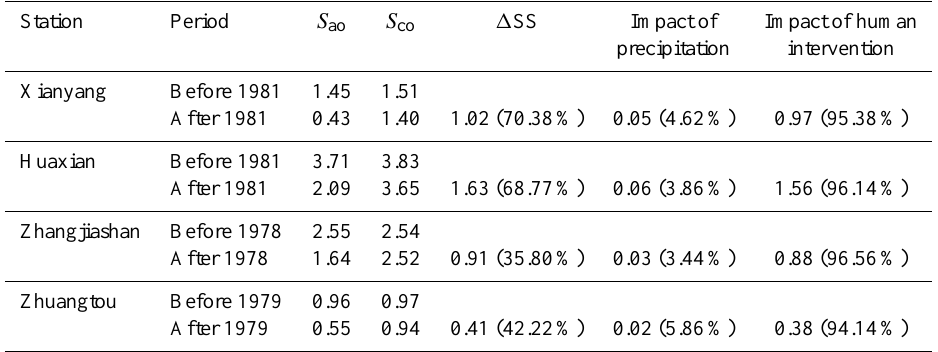
Table 7. The impact of precipitation and human intervention on sediment discharge decline after the change-point year at four stations in the Wei River basin (10 8 ta − 1